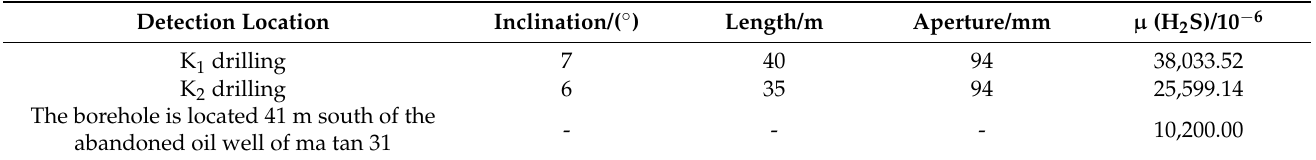
Table 2. Detecting results of borehole gas detection in return airway of I0104 1 05 working face.